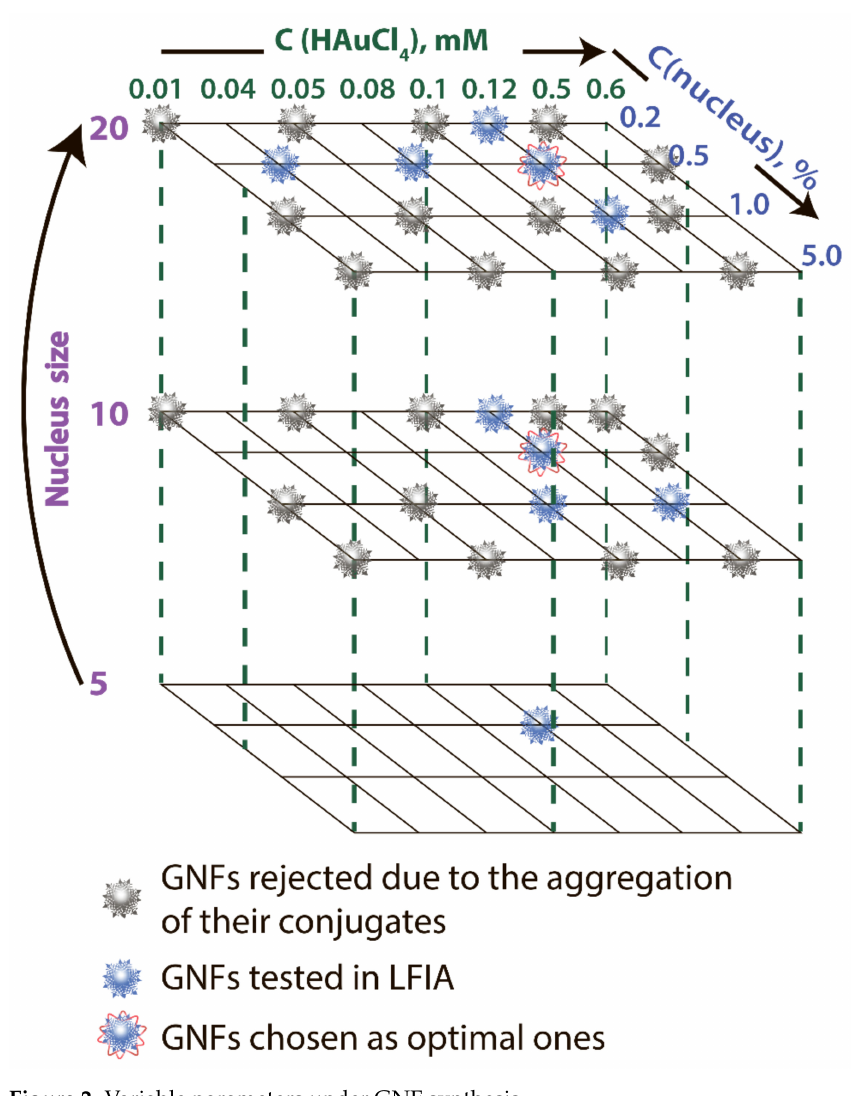
Figure 2. Variable parameters under GNF